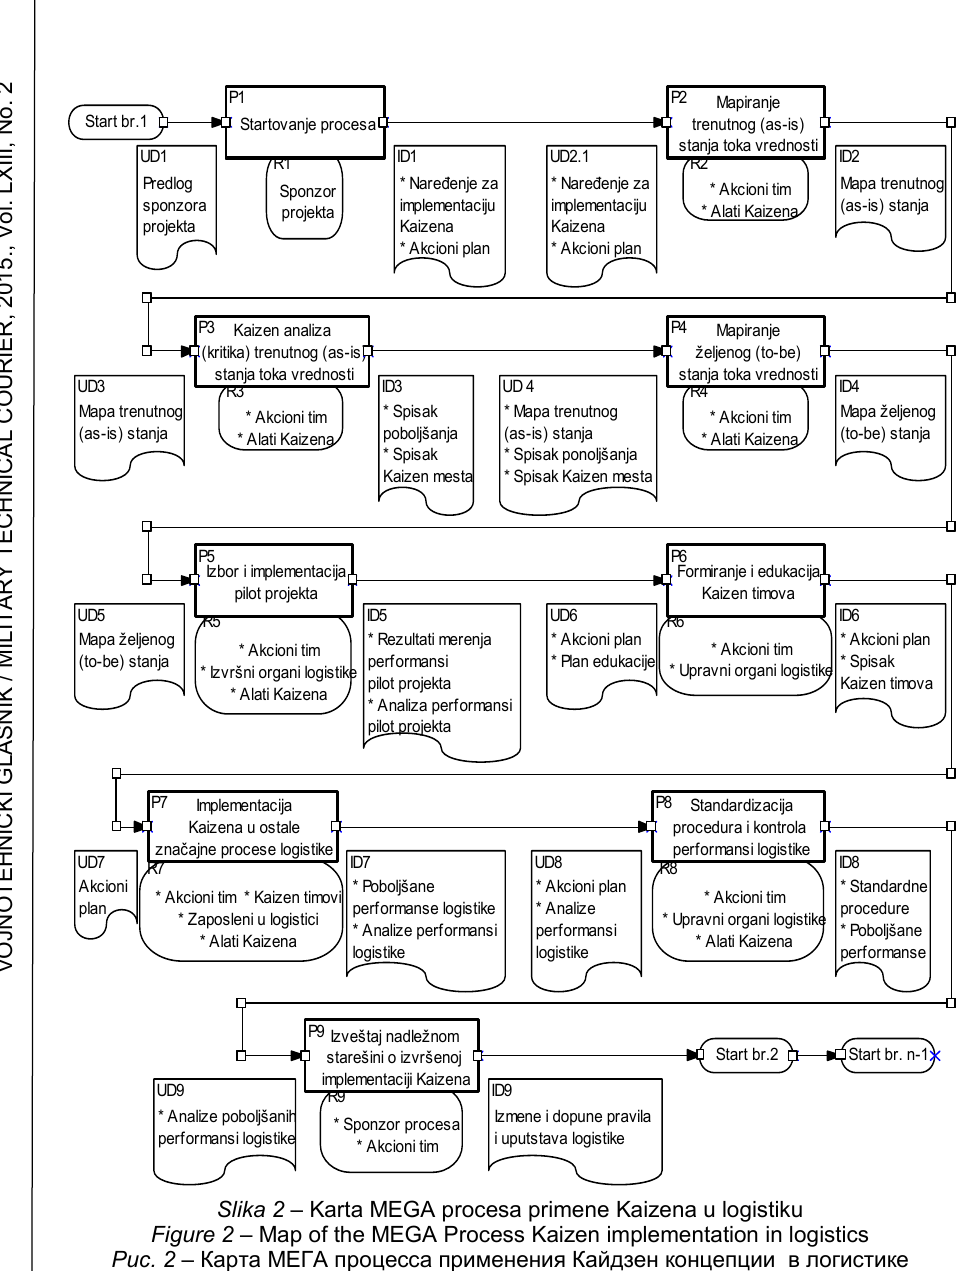
Figure 2 – Map of the MEGA Process Kaizen implementation in logistics Рис . 2 – Карта МЕГА процесса применения Кайдзен концепции в логистике Zbog specifi č nosti svake organizacije ne postoji jedna standardizo- vana, generi č ka i univerzalno primenljiva metodologija, ve ć samo okvir za primenu Kaizen programa. Na slici 2 prikazana je mapa opšteg